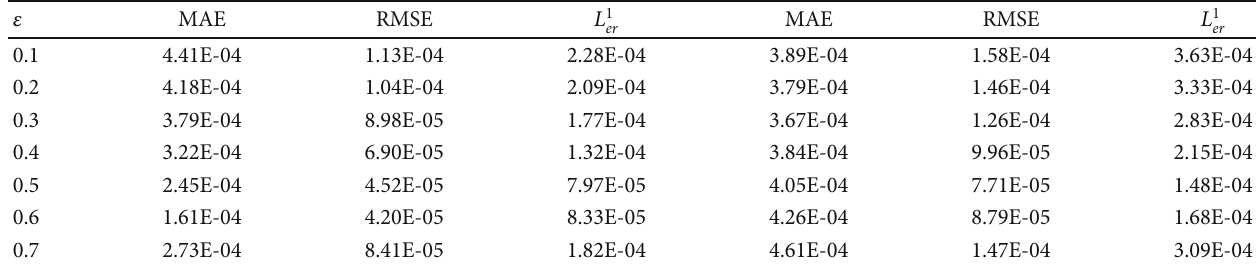
Table 4: Results for di ff erent values of ε in Example 1 with N and Neumann conditions.